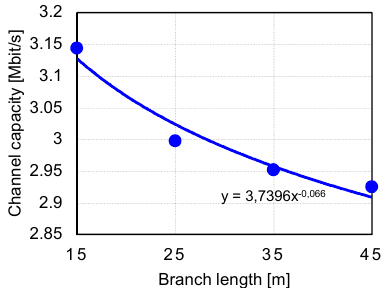
Figure 7. Channel capacity for different branch lengths.